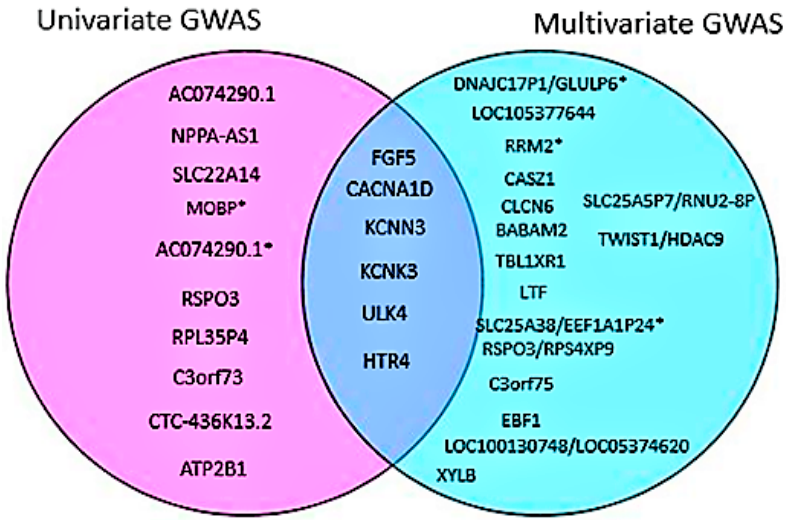
Figure 6. Venn diagram comparing the loci found by meta-analysis and multivariate GWAS analysis. Both methods identified known loci; the novel loci are indicated with an asterisk.